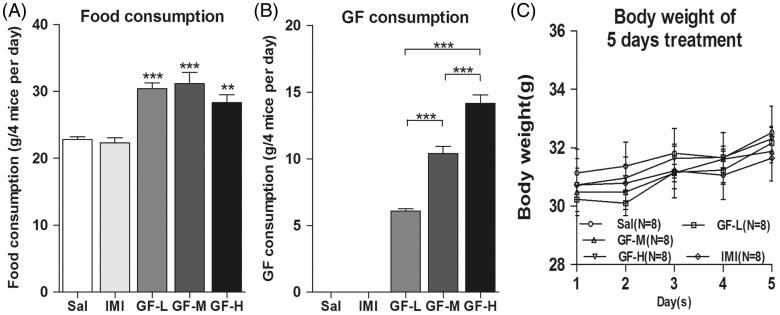
Increased food intake and normal body weight after GF-containing food administration for five days. CD-1 mice were fed with their regular mouse chow, a low dose of Griflola frondosa (GF powder:mouse chow =1:4, GF-L); a medium dose of Griflola frondosa (GF powder:chow food =1:2, GF-M); or a high dose of Griflola frondosa (GF powder:mouse chow =1:1, GF-H). For the positive control group, mice were i.p. injected with imipramine (15 mg/kg/day, IMI). Mice in the negative control group were i.p injected with saline (Sal). After 5 days of drug administration, the amount of food intake and the body weight were measured. Data were analyzed by one-way ANOVA and presented as the mean ± SE (post hoc Tukey’s test, *p < 0.05, **p < 0.01, ***p < 0.001). (A) The food intake of mice for the GF-containing food. (B) The actual amount of GF intake of mice for the different dosages. (C) Body weights of the mice after 5 days of GF-containing food treatment.